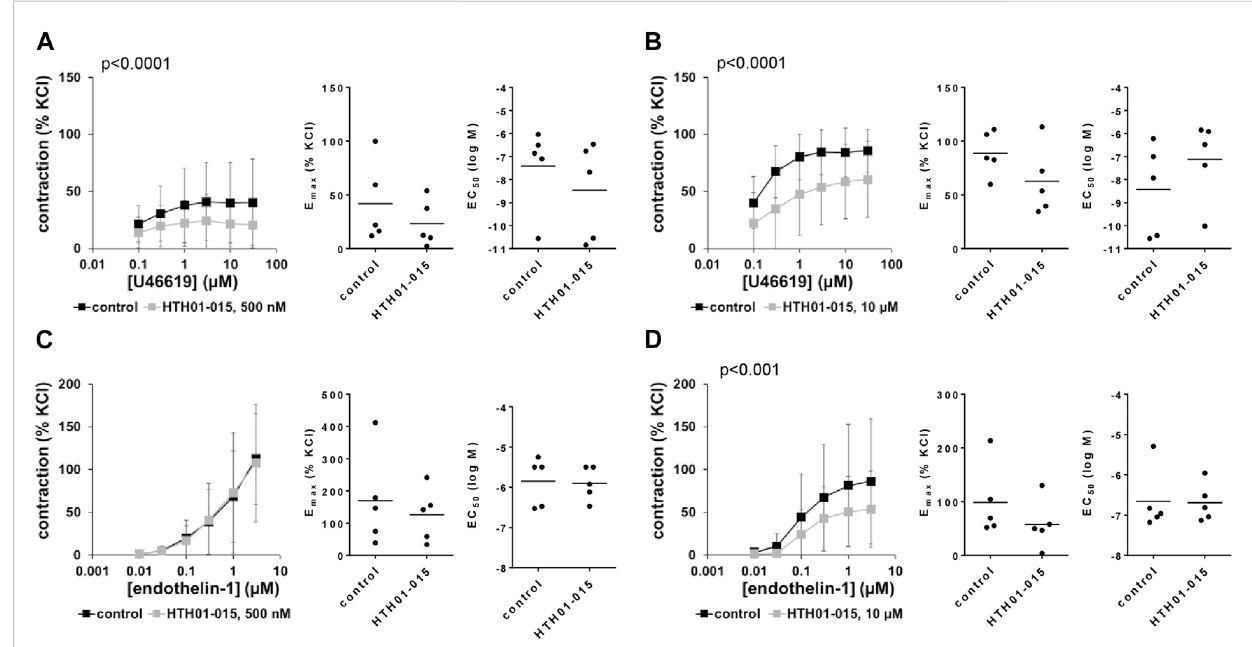
FIGURE 9 Effects of HTH01-015 on non-adrenergic contractions of human prostate tissues. Contractions of human prostate tissues were induced by U46619 (A,B) or endothelin-1 (C,D) in an organ bath, 30 min after addition of HTH01-015 in concentrations of 500 nM (A,C) or 10 µM (B,D) or of an equivalentamountofDMSO(controls),whichwasusedassolventforHTH01-015.Shownaredatafrom n =5independentexperimentsineachsubpanel, where tissues from n = 5patients wereused for both groups of asubpanel, resulting inpaired samples. Shown are means± SD from all experiments in concentration response curves with p values from two-way ANOVA for whole groups, and all single E max and EC 50 values from all experiments (calculated by curve fi tting) in scatter